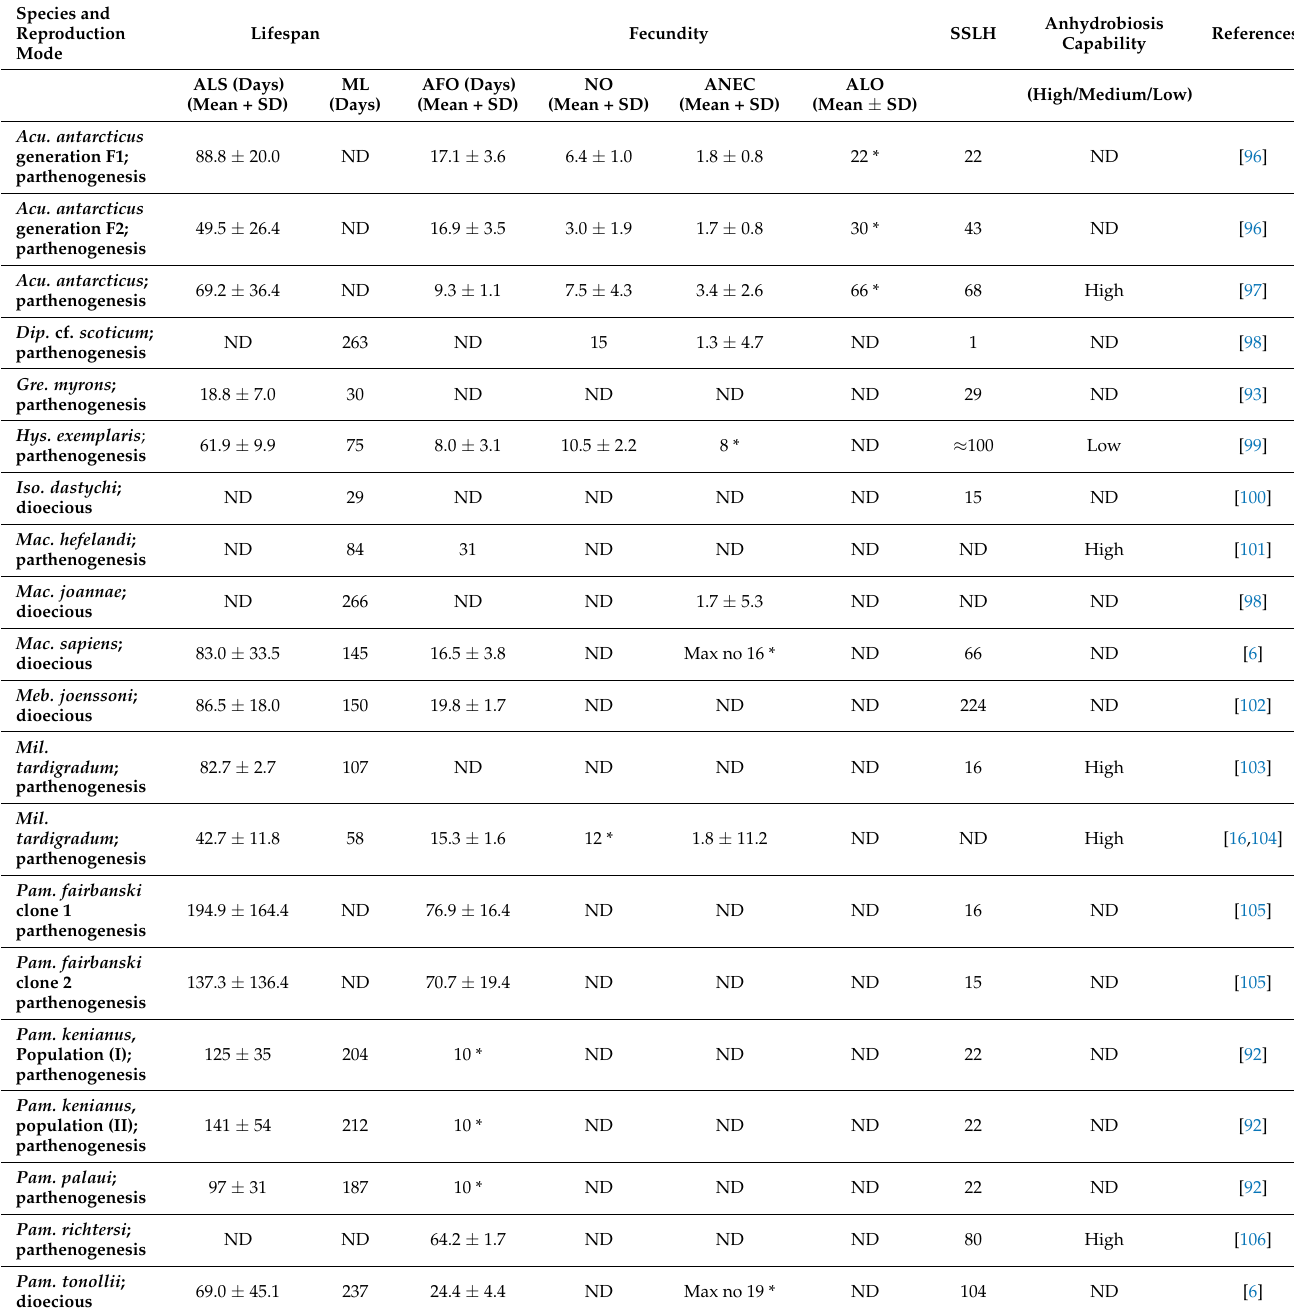
Table 1. Life-history traits in tardigrade species. ALS: average lifespan; ML: maximum lifespan; AFO: age at first oviposition; NO: number of ovipositions; ANEC: average number of eggs per clutch; ALO: age at last oviposition; SSLH: sample size in study of life-history traits; ND: no data; * = SD values are not reported; tardigrade genera abbreviations according to Perry et al.